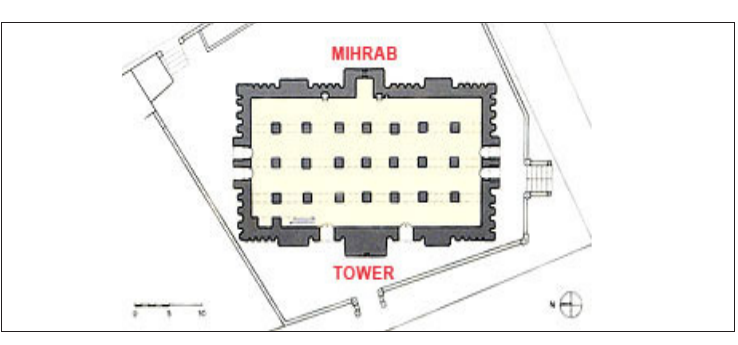
Figure 13: Great Mosque of Mopti, plan showing the main tower and mihrab and qibla wall